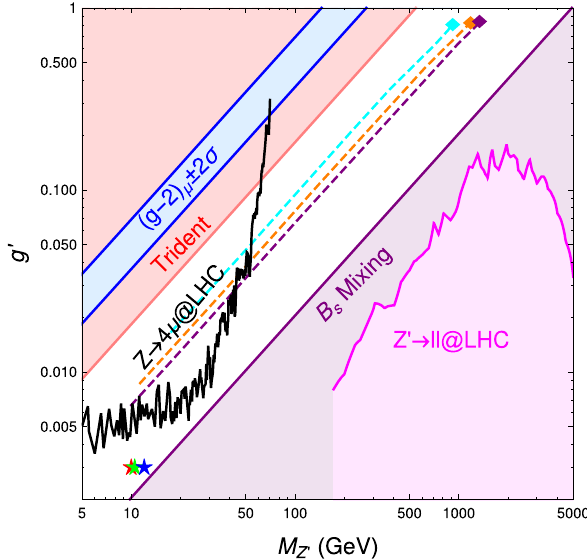
Fig. 4 The benchmarks in our model to fit AMS-02 positron data. Here cyan, orange and purple diamonds (red ,green and blue stars) respectively corresponding to M N = 1 , 1 . 5 , 2 TeV for N N → Z (cid:3) Z (cid:3) ( N N → Z (cid:3) H 0 ) annihilation channel. For completeness, various limits in Fig. 3 are